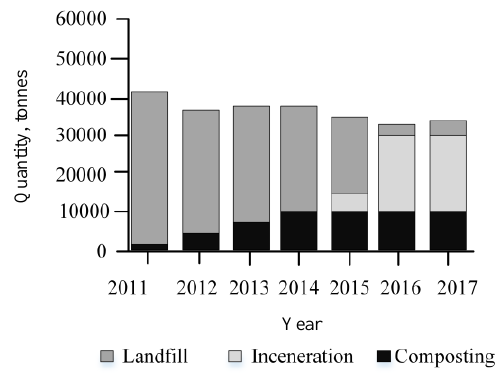
Fig. 2. The final destination of urban waste in Terceira Island between the years 2011–2016